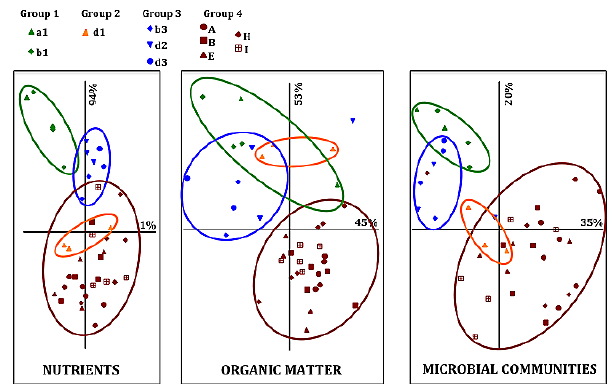
Fig. 2. NMS ordination biplots for soil nutrient supply (PRS), or- ganic matter composition (NMR), and microbial community struc- ture (PLFA) for the natural and the novel ecosystems. Each point on the ordination corresponds to one site. Descriptions of soil type and dominant vegetation for each ecosite and reclamation treatment are given in Table